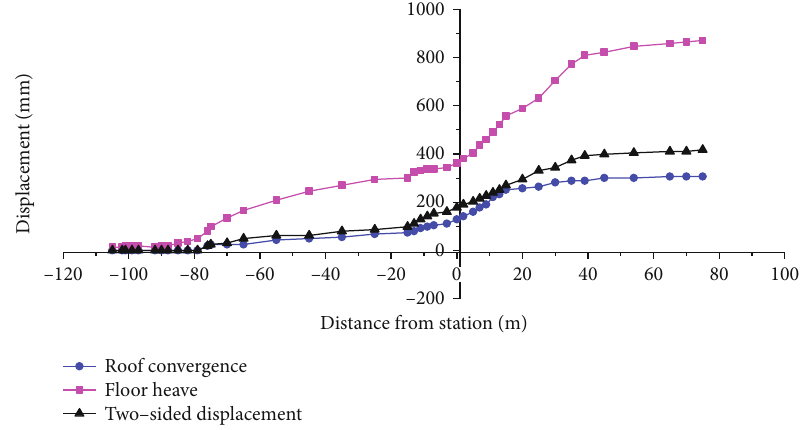
Figure 13: Deformation of roadway at various advancing